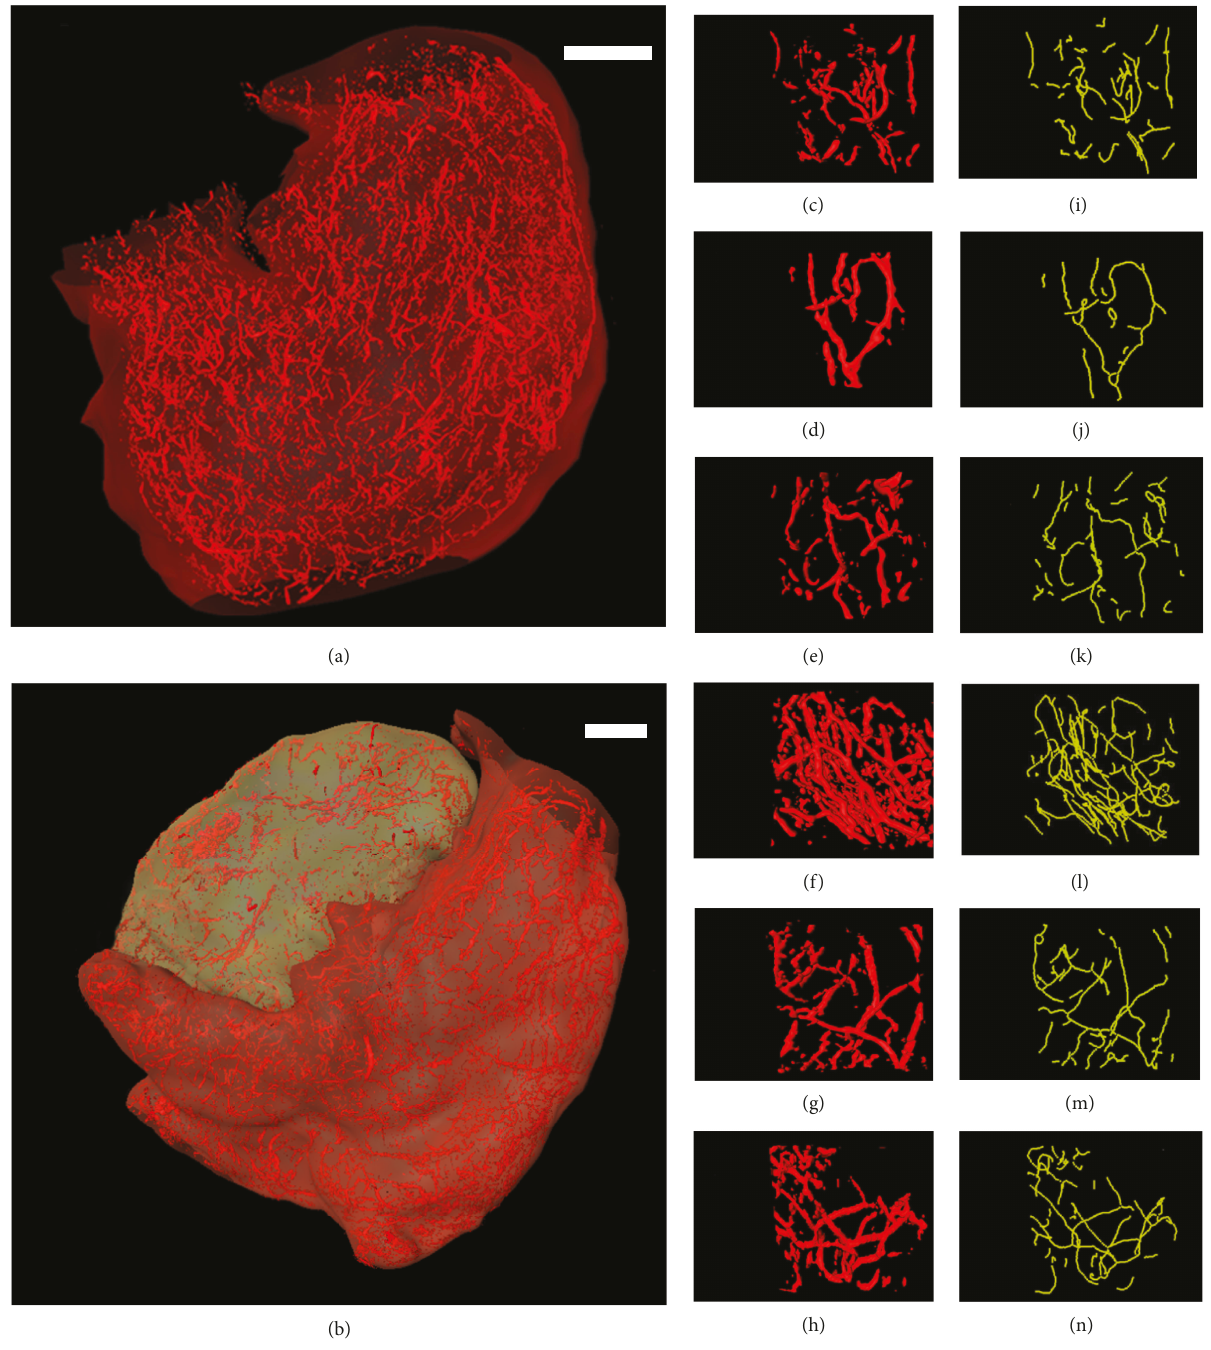
Figure 3: 3D model of a normal stomach and one with a tumor. (a) 3D model of a normal stomach; (b) 3D model of a stomach with cancer; (c – h) volume of interest (VOI) in models A and B; (i – n) centerline extraction results of (c – h). Bar: 1